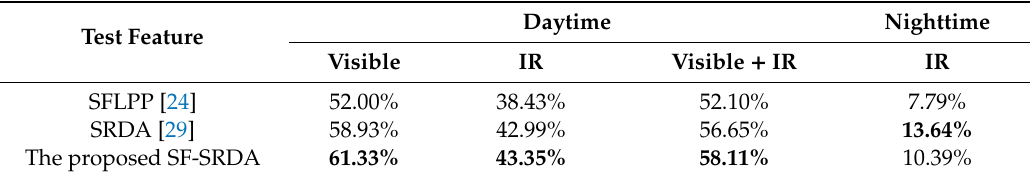
Table 6. Fine-grained results of sub-division test sets.